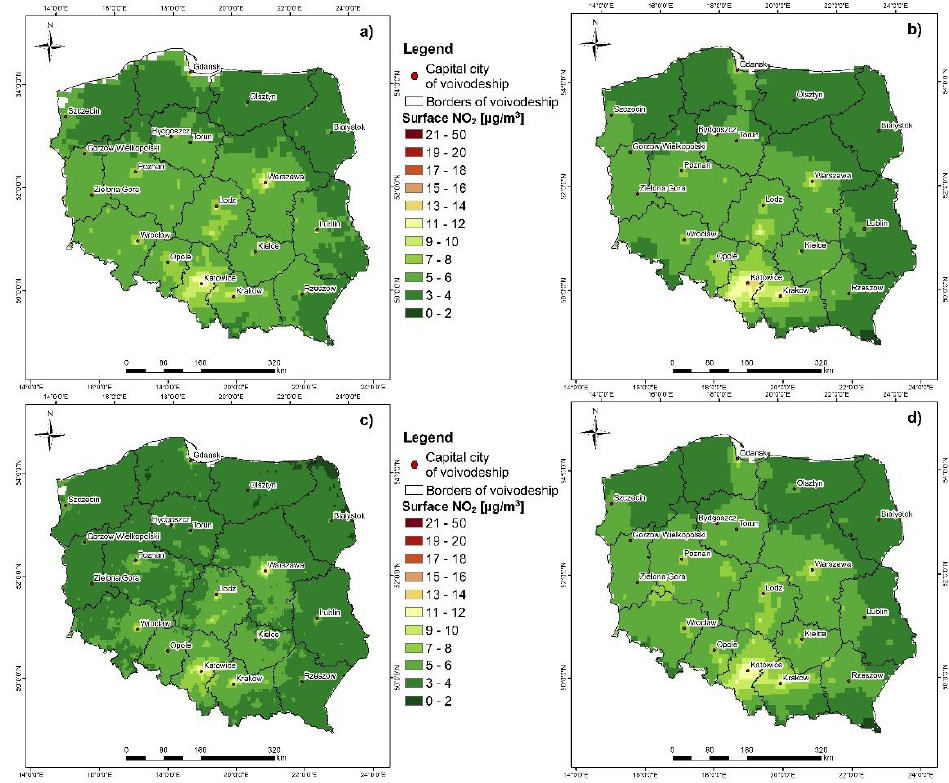
Figure 7. Maps of estimated surface mass concentrations of NO 2 (μg/m 3 ) for yearly averages: ( a ) based on the RF model for 2019; ( b ) based on the CAMS ensemble median for 2019; ( c ) based on the RF model for 2020; ( d ) based on the CAMS ensemble median for 2020. The red points are the capital cities of the voivodeships (NUTS-2).